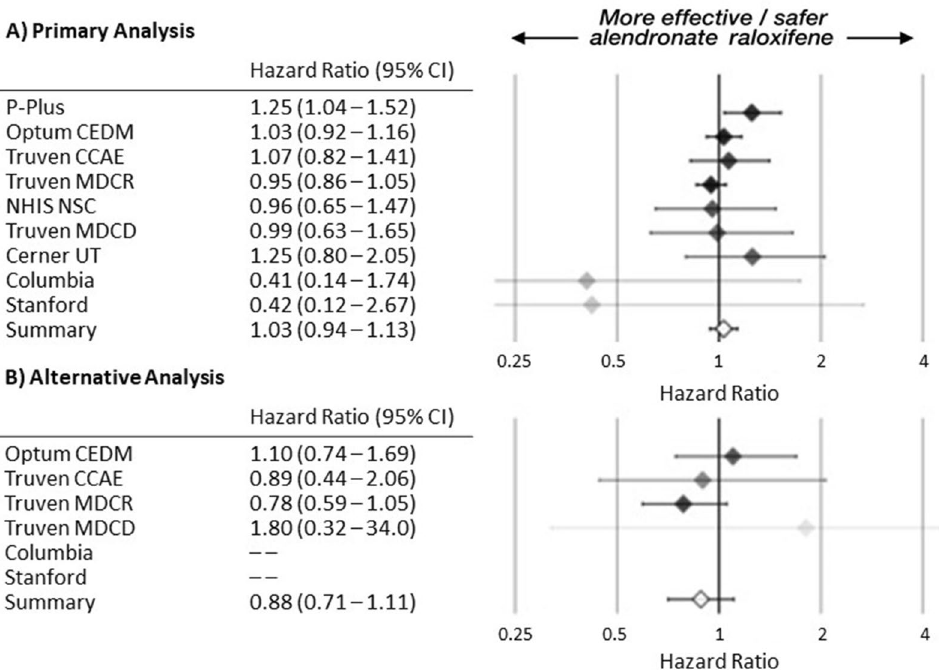
Fig. 1. ( A ) Primary and ( B ) alternative analysis hazard ratios (HRs) for hip fracture. More precise estimates have greater opacity. Missing HR from data source with 0 raloxifene